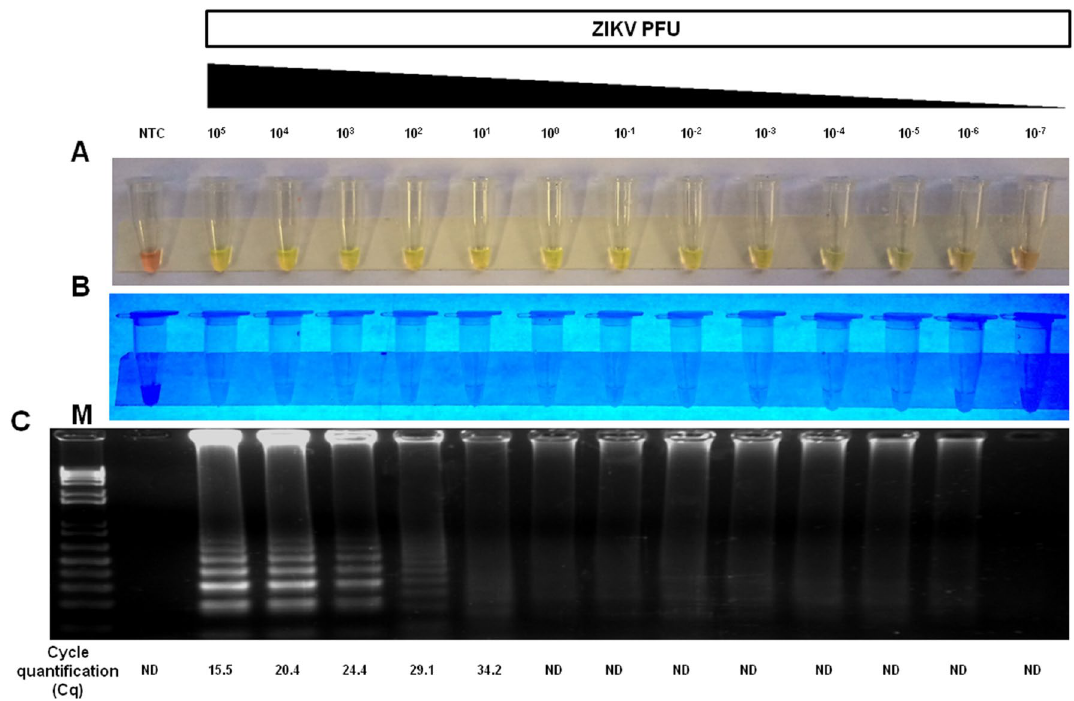
Figure 4. Analytical sensitivity of ZIKV RT-LAMP in human serum. The sensitivity of RT-LAMP was determined based on the last dilution at which the viral genome was detected by RT-LAMP assay. The sensitivity of RT-LAMP was determined by spiking different amounts (10 5 to 10 –7 PFU) of ZIKV in human serum sample uninfected and then testing by RT-LAMP directly without RNA extraction. The amplification products were observed by naked eye under natural light ( A ), under UV irradiation ( B ), agarose gel electrophoresis from RT-LAMP ( C ) and agarose gel electrophoresis from RT-PCR. M: molecular weight marker. NTC (non-template control): water. ND (Not detected). To compare the results of RT-LAMP with RT-qPCR, viral RNA was extracted from the same dilutions and assayed. Orange color: negative reaction for ZIKV; Greenish yellow color: positive reaction for ZIKV.